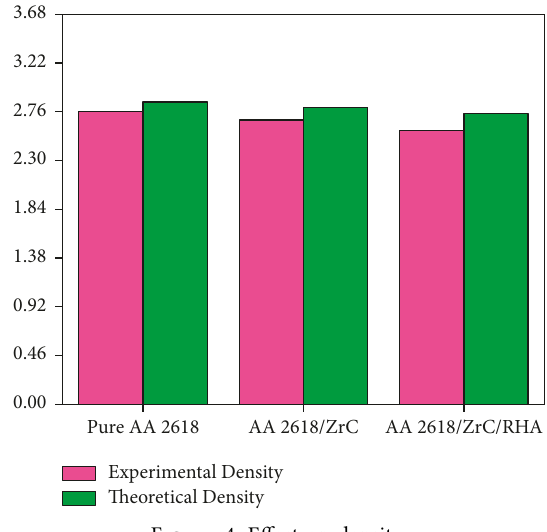
Figure 4: Effect on density. Table 5: Output of the